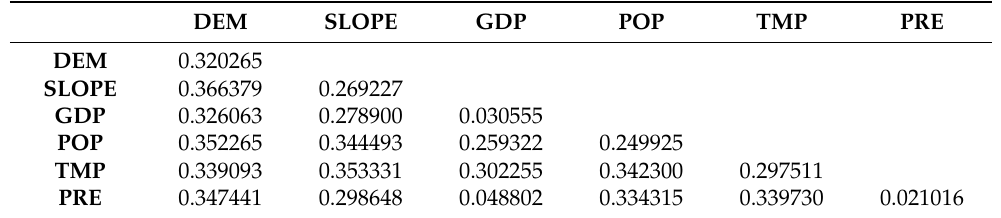
Table A3. The force (q-value) among any two influencing factors on Patch density (PD) interactively in 1990.